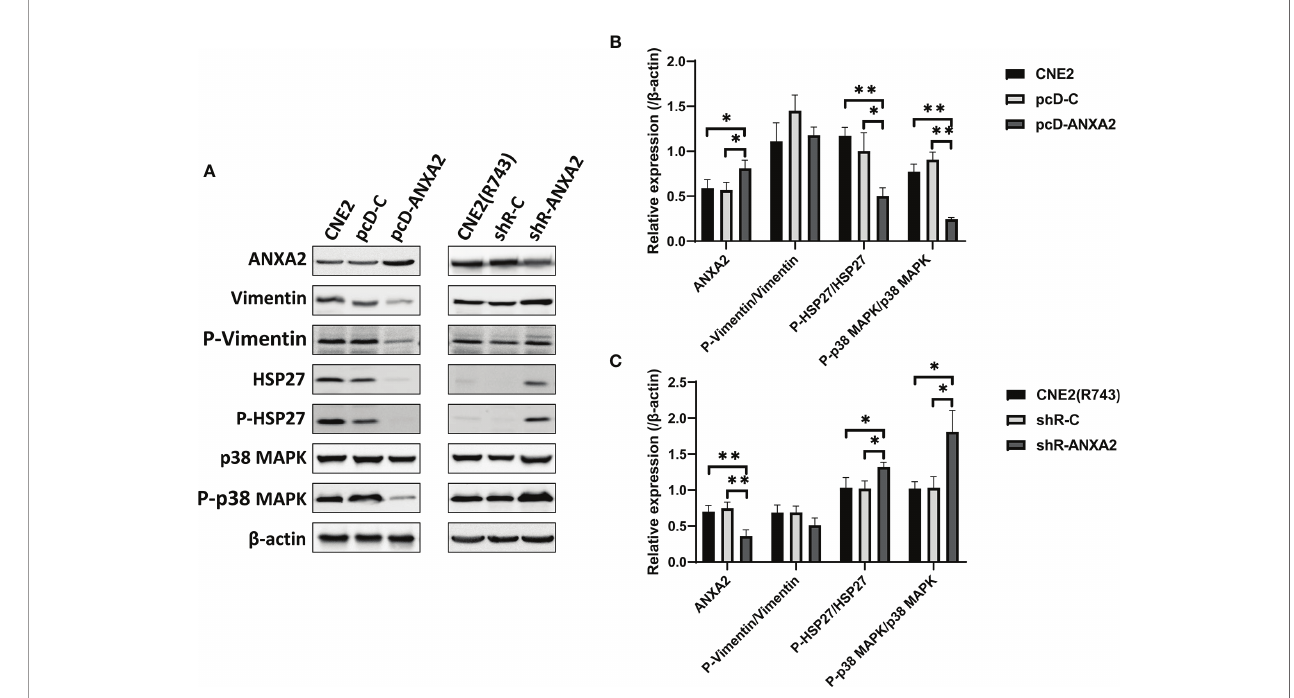
FIGURE 7 | p38 MAPK-HSP27 pathway is activated by ANXA2 knockdown and inactivated by ANXA2 overexpression. (A) Western blotting determines the expression of the p38 MAPK-HSP27 pathway-associated proteins in NPC cells 48 h post-exposure to X-ray irradiation at a dose of 4 Gy, and b -actin serves as a loading control; (B) lower phospho-HSP27/HSP27 and phospho-p38MAPK/p38MAPK expression are determined in pcD-ANXA2 cells than in pcD-C and CNE2 cells; (C) higher phospho-HSP27/HSP27 and phospho-p38 MAPK/p38 MAPK expression are detected in shR-ANXA2 cells than in shR-C and CNE2(R743) cells. All values are presented as mean ± SD, n = 3. * P < 0.05, ** P < 0.01. P-Vimentin, phospho-Vimentin; P-HSP27, phospho-HSP27; P-p38MAPK,